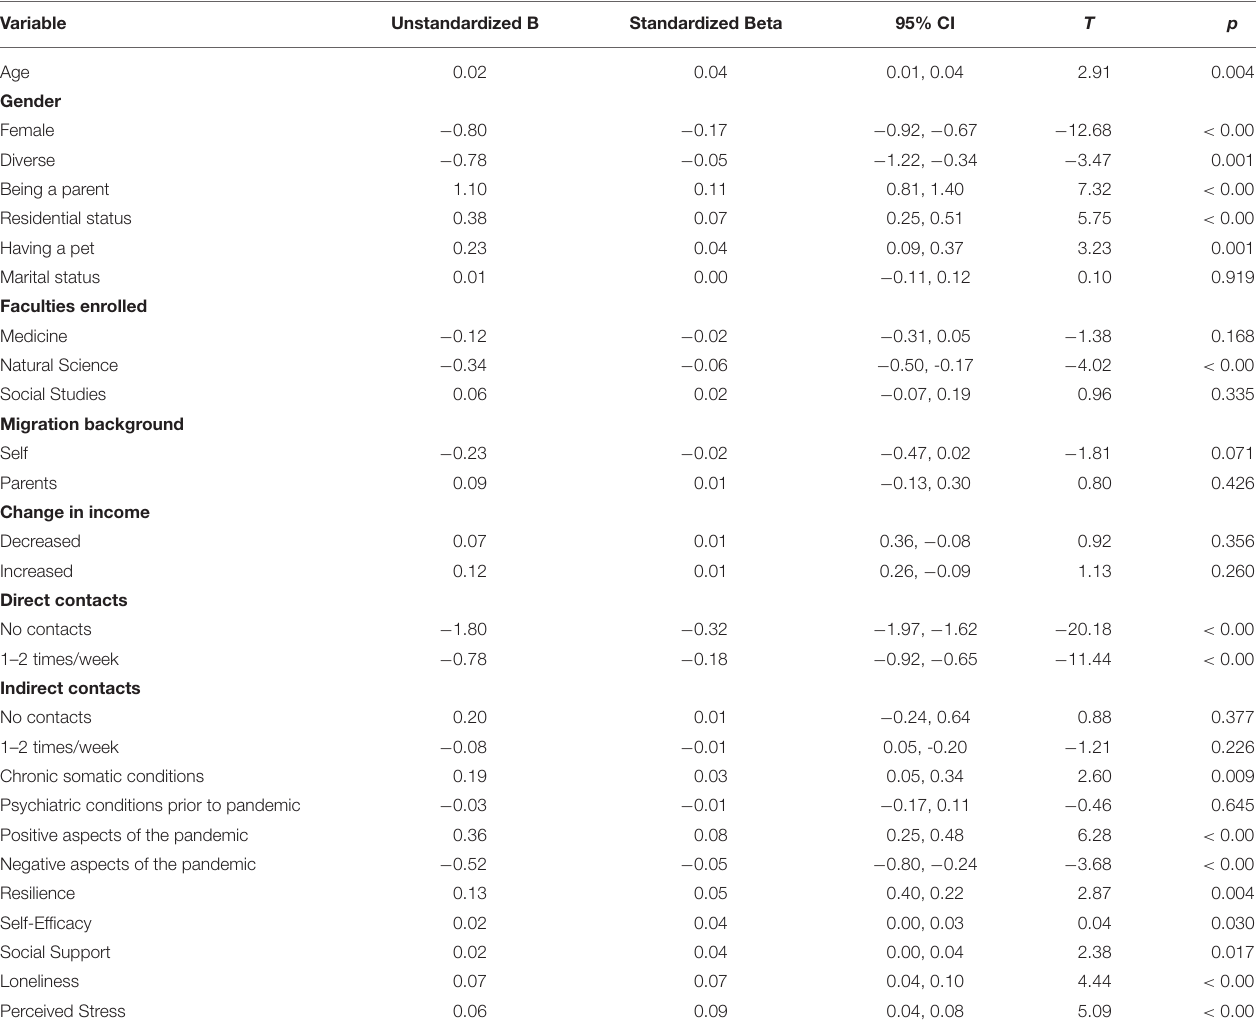
TABLE 4 | Linear regression analysis for predictors of harmful alcohol use measured by AUDIT-C (Alcohol Use Disorders Identification Test).